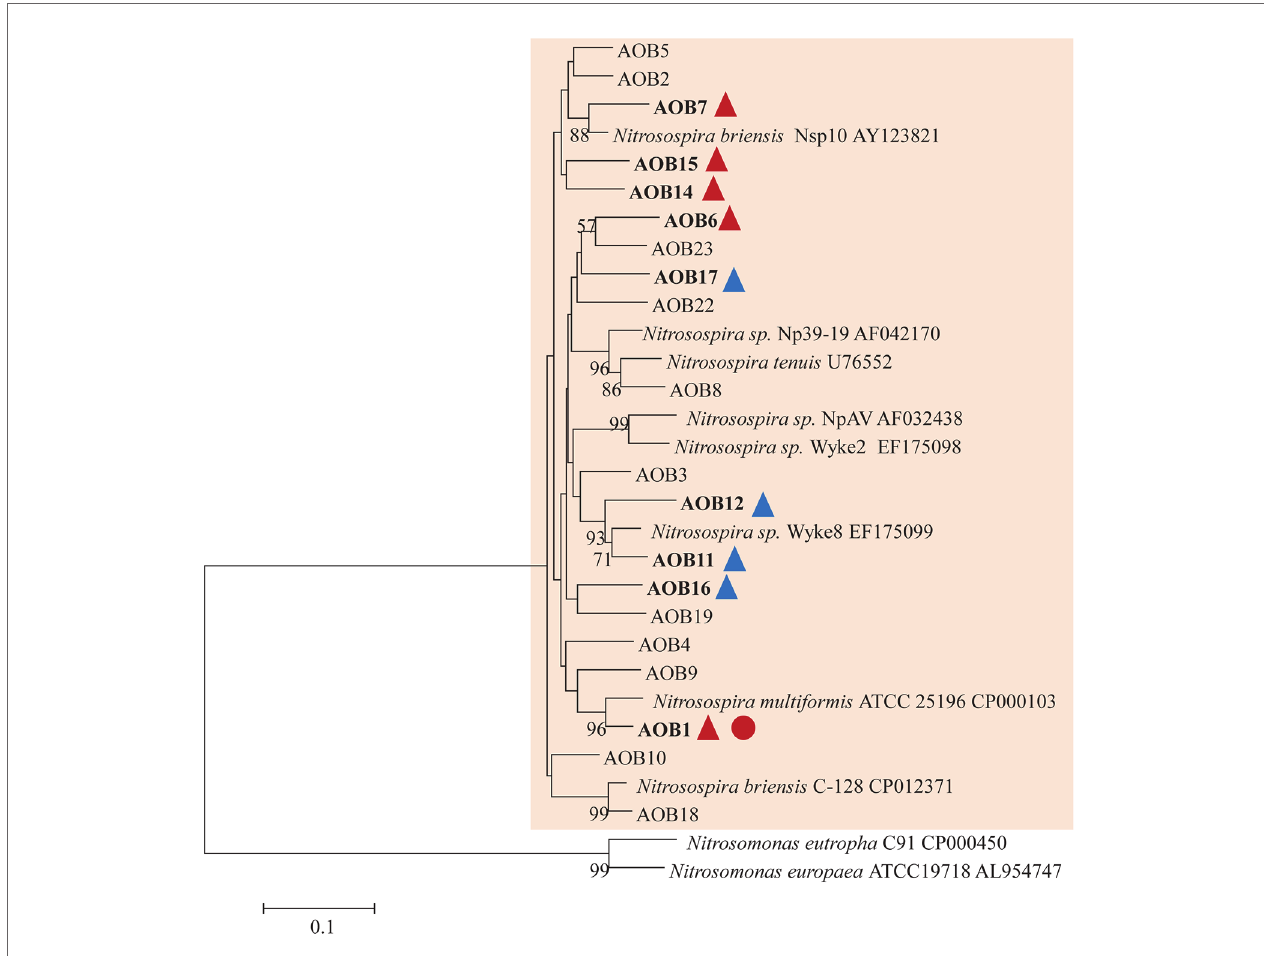
FIGURE 4 | Neighbor joining tree for AOB partial amoA top 20 OTUs (covered 98.2% of total sequences). The scale bar represents 10% nucleic acid sequence divergence, and bootstrap values (>50%) are showed at branch points. OTUs are shown in bold if they were significantly changed by N treatment. Up triangles indicate a significant difference between values for control and AS treatments while circles indicate a significant difference between values for control and compost treatments. Red color indicates a significant higher abundance than control while blue color indicates a lower